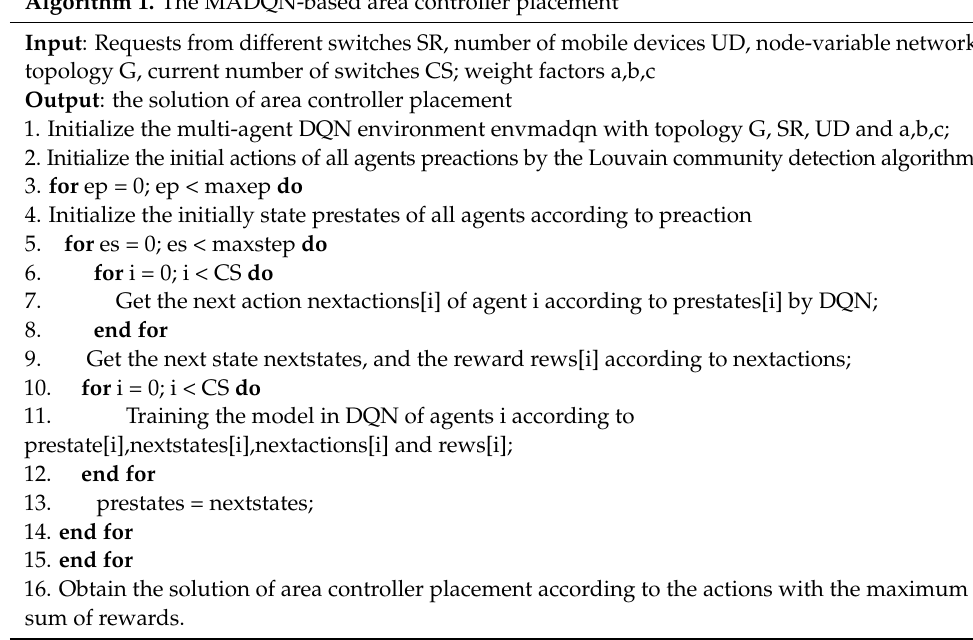
Algorithm 1. The MADQN-based area controller placement